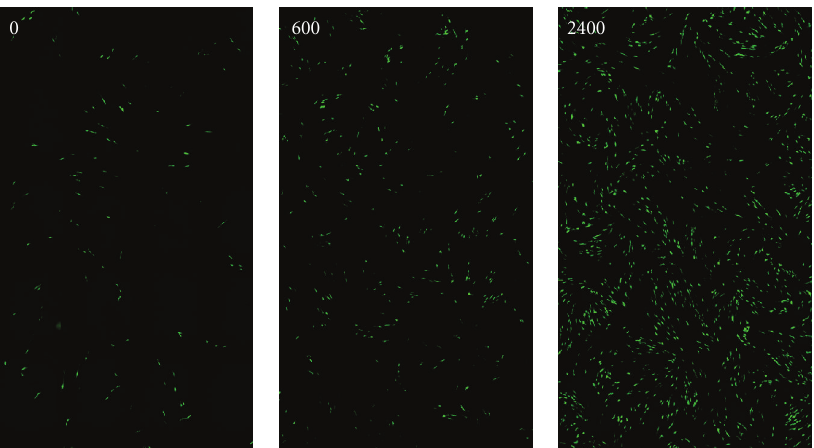
Figure 1: Spinoculation increases infection of CRL-2703 human fibroblasts by amphotropic retroviral vectors produced by Plat-A cells. Cells were infected with an EGFP vector without spinoculation or with spinoculation at 600 g and 2400 g (in each case 2 hours at 15 ◦ C). Representative microscope fields demonstrating increases in the fraction of infected cells (exhibiting green fluorescence) are